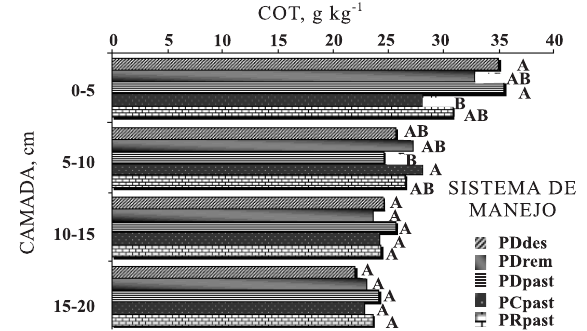
Figura 2. Carbono orgânico total (CO) do solo nos sistemas de manejo e camadas na integração agricultura-pecuária aos 190 dias após a semeadura (DAS) do milho. Otacílio Costa-SC, 2004. Letras maiúsculas comparam os sistemas de manejo em cada camada. Médias seguidas por letras iguais não diferem a 5 % (Tukey).